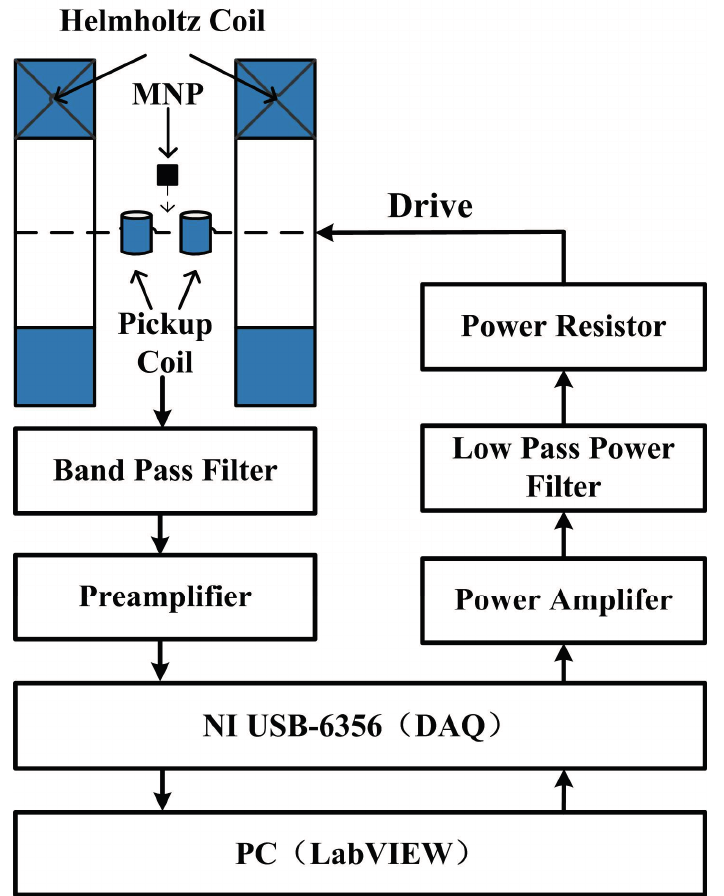
Figure 1. System structure of the MNPT. DAQ, data acquisition